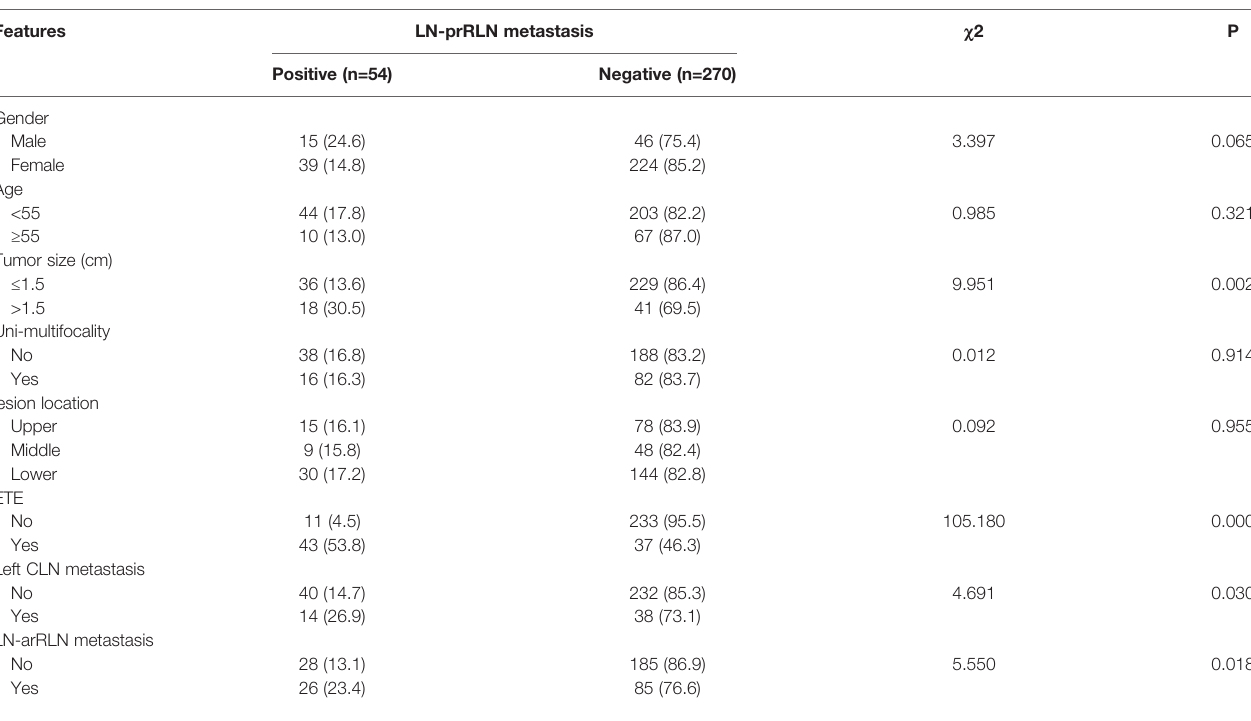
TABLE 7 | Univariate analysis of predictor for LN-prRLN in cN0 PTC.